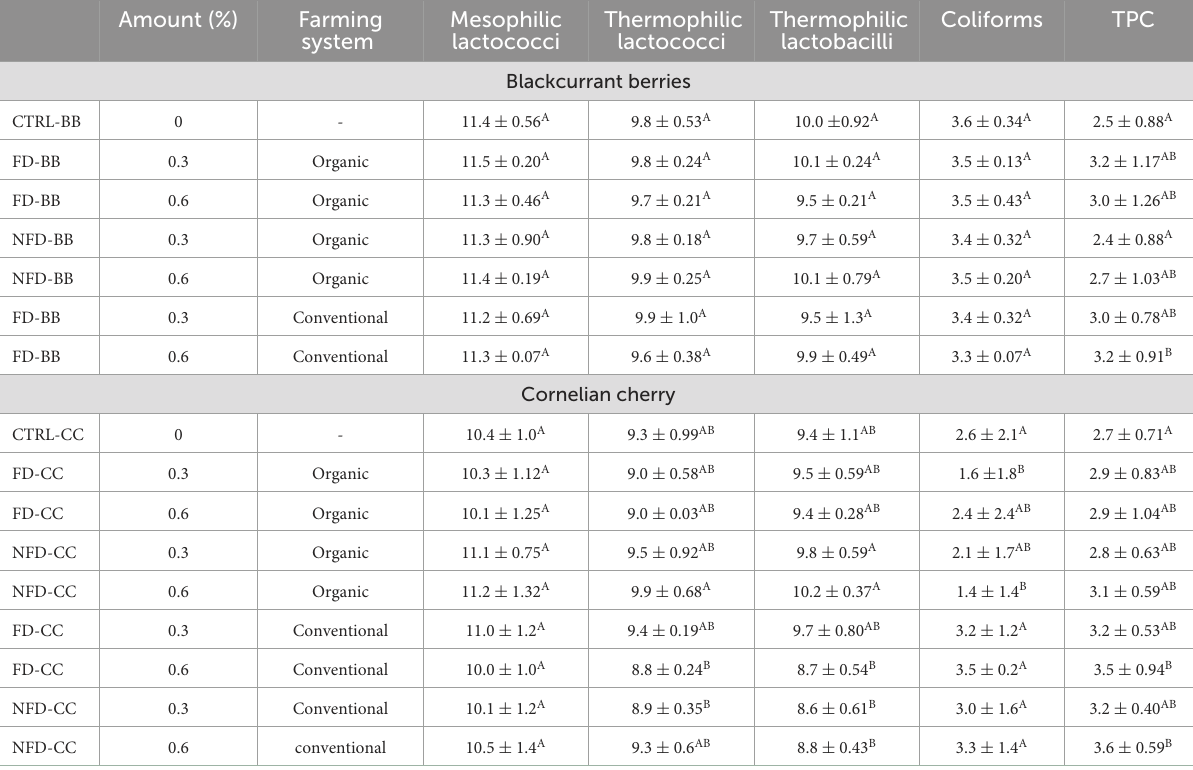
TABLE 2 Microbial counts and Total Polyphenol Content (TPC) in cheeses after 4 weeks of ripening. Amount (%)